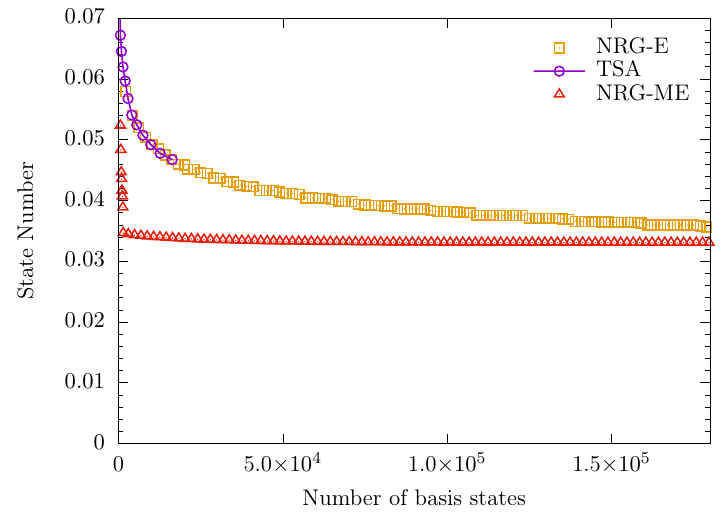
Figure 4: A comparison between the numerical renormalization group (NRG-E) re- sults of Fig. 2(b) and the modified numerical renormalization group with matrix element ordering (NRG-ME). We see that the alternative ordering leads to massive improvement in the convergence of the ground state energy (and similar improve- ment is seen in low-lying excited states) for fixed number of basis states. NRG-ME = 600, ∆ N = 120 with a total of 280,000 basis was performed with N s s